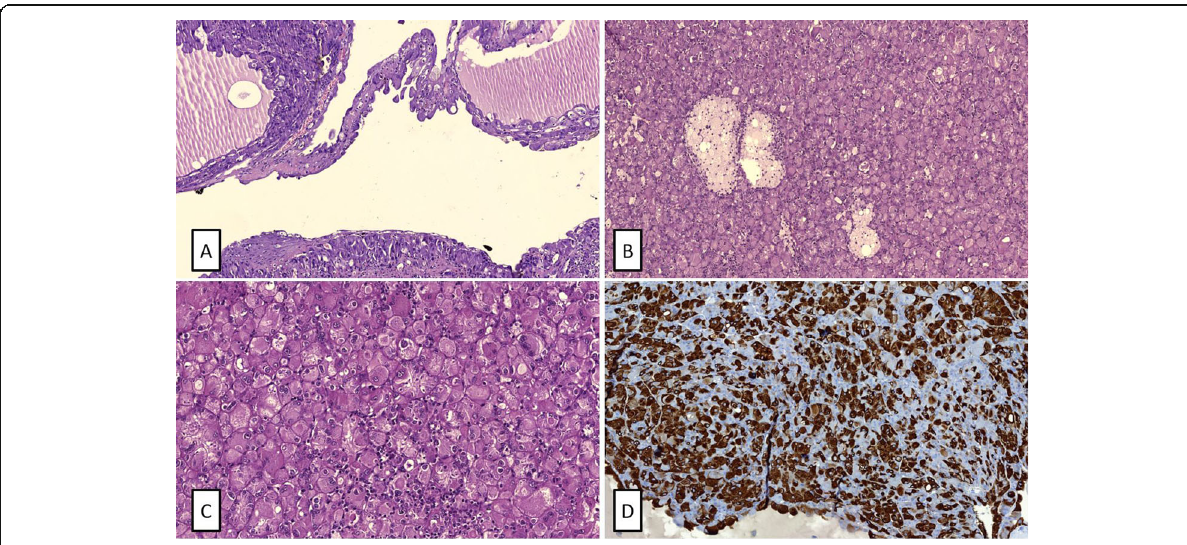
Fig. 7 Eosinophilic, solid and cystic renal cell carcinoma (ESC-RCC). Growth patterns alternate cystic areas ( a HE, 40x) and solid areas of oncocytic cells ( b and c HE, 40x and 100x). Diffuse staining of cytokeratin 20 ( d